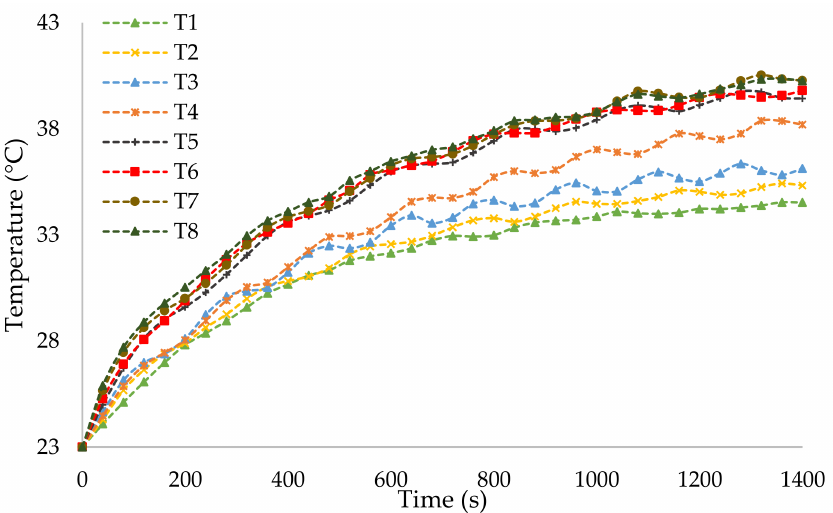
Figure 11. The experimental results: the temperature evolution of the module regarding the eight thermocouples embedded on top surfaces of the